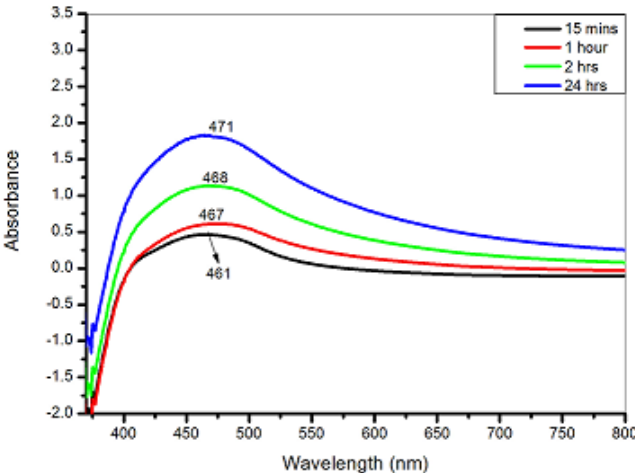
Figure 2. UV–Visible absorption of prepared AgNPs. Figure 2. UV – Visible absorption of prepared AgNPs. The XRD experiment confirmed the size and crystal nature of bio-synthesized Ag- NPs using the bark-extract of A. indica . The XRD analysis clearly showed that AgNPs synthesized by silver ions reduction by aqueous extract of the bark of A. indica possessed a crystalline nature (Figure 3). XRD pattern of these AgNPs showed various Bragg’s reflections revealing the face-centered cubic structure because of excellent concurrence Figure 2. UV – Visible absorption of prepared AgNPs. with the JCPDs (89–3722) standard card. The XRD analysis of AgNPs showed that the main diffraction peak centered at 2 θ = 38.12 ◦ , corresponding to the crystal plane with Miller indices (1 1 1), which is the characteristic peak for fcc structure. The average size of crystallite AgNPs was calculated applying the Debye Scherrer formula presented in Equation (1) on a high-intensity peak